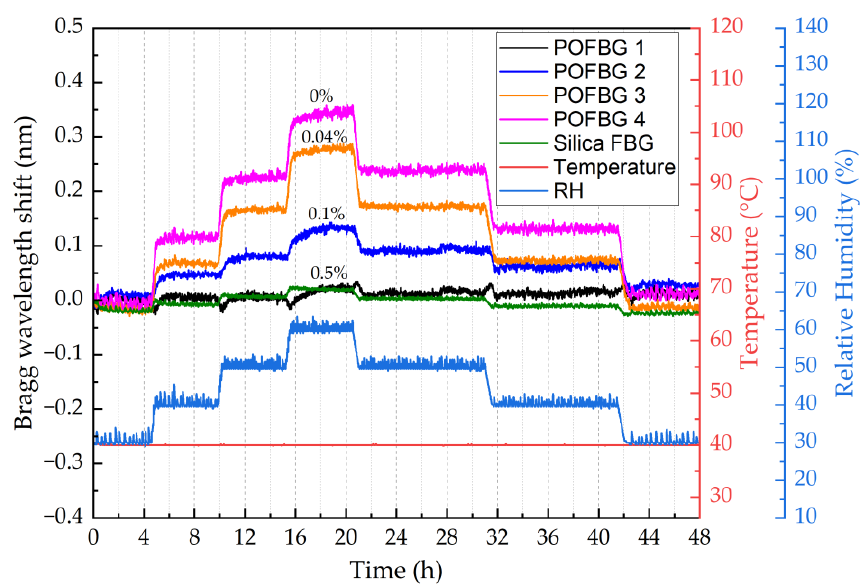
Figure 13. Relative humidity response of sensors over time.